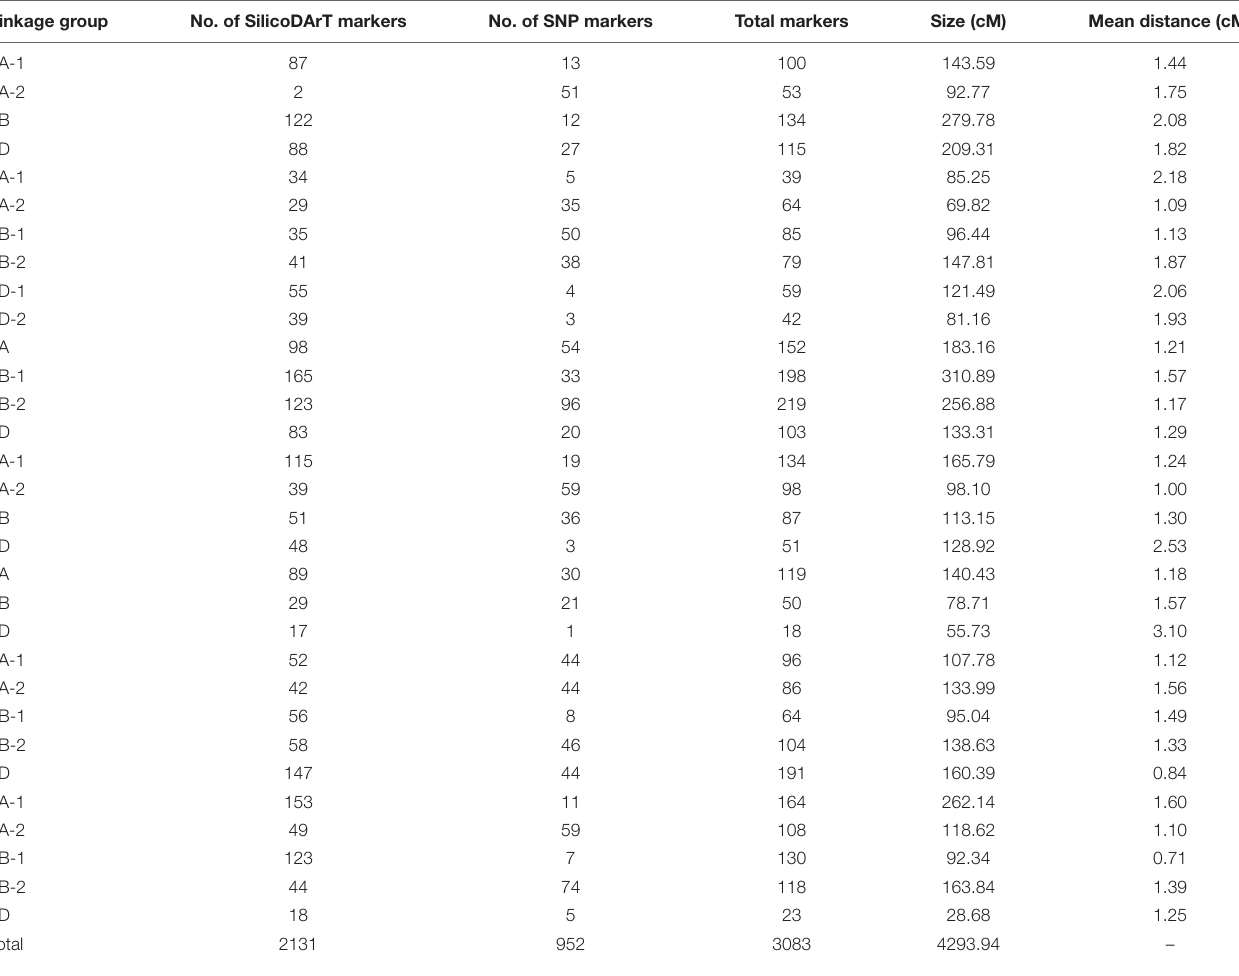
TABLE 2 | Summary of the linkage groups based on the F 3 lines derived from the cross Mingxian169/Baidatou. Linkage